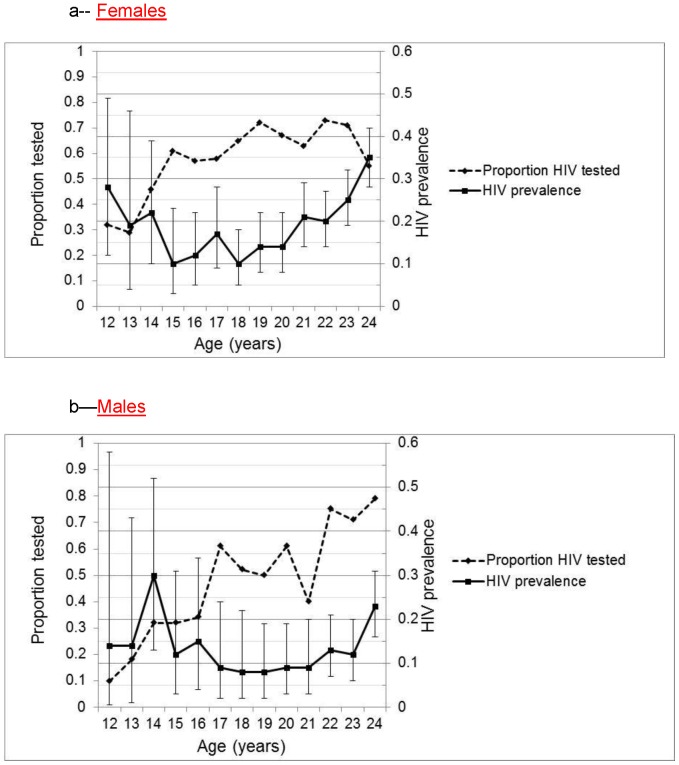
Proportion of females and males who underwent testing and the HIV prevalence among those tested, by age.The dashed line represents the proportion who underwent HIV testing by age. The solid line is the HIV prevalence among those tested with error bars representing 95% confidence intervals. Figure 1a–Females. Figure 1b–Males.